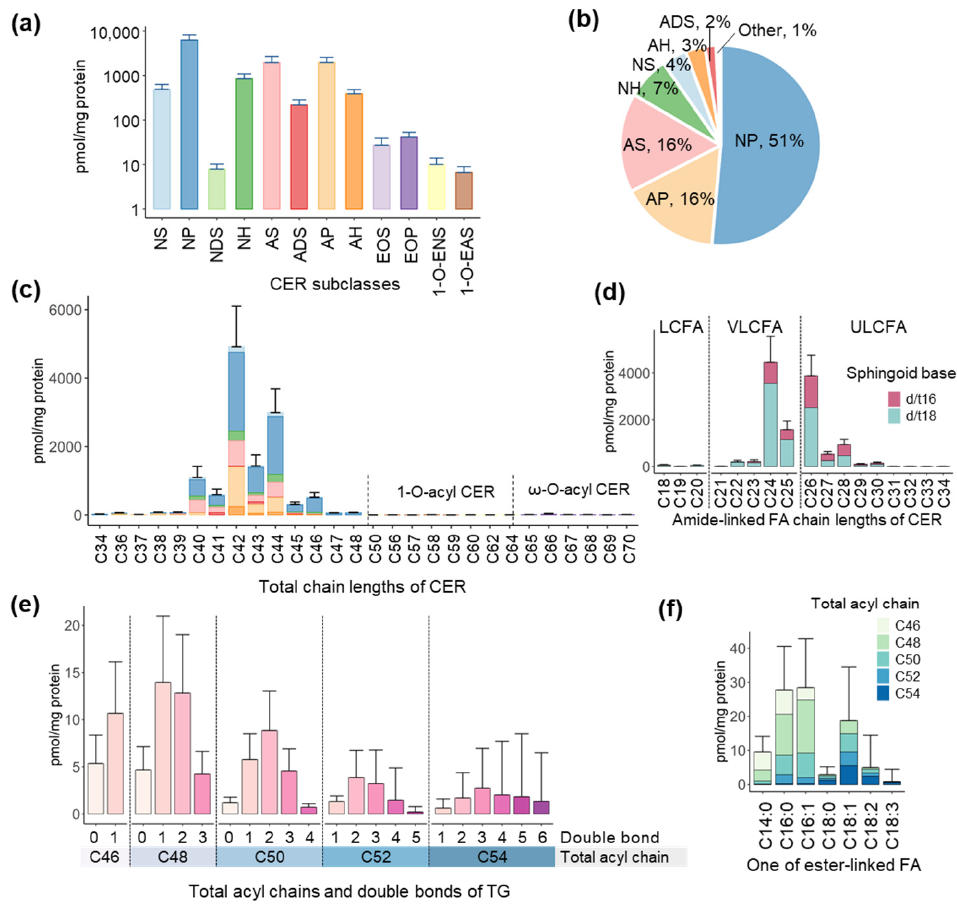
Figure 1. Profiles of ceramides (CER) and triacylglycerols (TG) in the skin surface of the participants. Skin surface lipids were extracted from tape strips and analyzed by LC ‐ MS/MS. ( a ) Quantification of CER subclasses (values are means + standard deviations; SD and y ‐ axis is a log ‐ scale) using a product ion related to sphingoid bases and ( b ) their proportions. Non ‐ hydroxy fatty acid (FA) [N], α‐ hydroxy FA [A], esterified ω‐ hydroxy FA [EO], 1 ‐ O ‐ acyl FA [1 ‐ O ‐ E], dihydro ‐ sphingosine [DS], sphingosine [S], phytosphingosine [P], and 6 ‐ hydroxy sphingosine [H]. Distributions of ( c ) total chain lengths (color indicates CER subclass as in ( a , b , d ) amide ‐ linked FA chain lengths in CER. Values are means + SD. LCFA: long ‐ chain fatty acid, VLCFA: very ‐ long ‐ chain fatty acid, ULCFA: ultra ‐ long ‐ chain fatty acid. ( e ) Quantification of TG with various acyl moieties of chain length and desaturation using a product ion related to one of FA in TG. Values are means + SD. ( f ) Distribution of TG categorized by the targeted one of FA and total acyl chain lengths. 3.2. Associations of TG ‐ FA with Ester ‐ Linked FAs of acylCER In this study, we quantified two types of ω‐ O ‐ acylCER, E(18:2)O(X)S(18) and E(18:2)O(X)P(18) with amide ‐ linked FA from C28 to C34 (Figure S4a,b) and used the com ‐ bined ω‐ O ‐ acylCER (the sum of EOS and EOP) for further analysis. To identify the overall relationships between TG containing C18:2 and ω‐ O ‐ acylCER, we built a Spearman cor ‐ relation heatmap (Figure 2a). TG containing C18:2 with longer acyl chain lengths (C52 ‐ C54) generally exhibited more strongly positive correlations with ω‐ O ‐ acylCER compared to those with C48 and C50. Among them, TG 52:4(18:2) and TG 54:2(18:2) showed signifi ‐ cantly positive correlations with overall ω‐ O ‐ acylCER (Figure 2a). To clarify these rela ‐ tionships, we conducted trend tests using ANOVA with contrast. Total ω‐ O ‐ acylCER and ω‐ O ‐ acylCER with amide ‐ linked FA of C29, C32, C33, and C34 were increased across the quartiles of TG 52:4(18:2) content (Figure 2b). In addition, total ω‐ O ‐ acylCER and ω‐ O ‐ acylCER with amide ‐ linked FA of C31, C32, C33, and C34 were increased across the quar ‐ tiles of TG 54:2(18:2) content (Figure 2c).